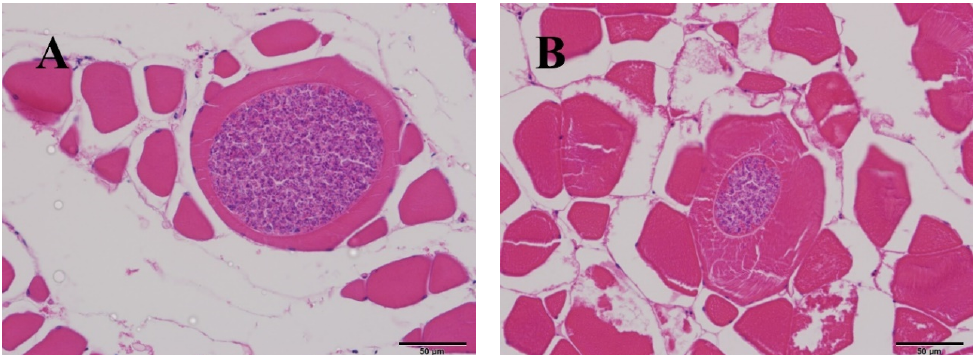
Figure 2. Histological analysis of abdominal and dorsal muscle in Pacific bluefin tuna ( Thunnus orientalis ) positively infected with Kudoa hexapunctata . H&E staining revealed: ( A ) abdominal muscle of the fifth sample; ( B ) abdominal muscle of the fifth sample. Scale bar = 50 μm.